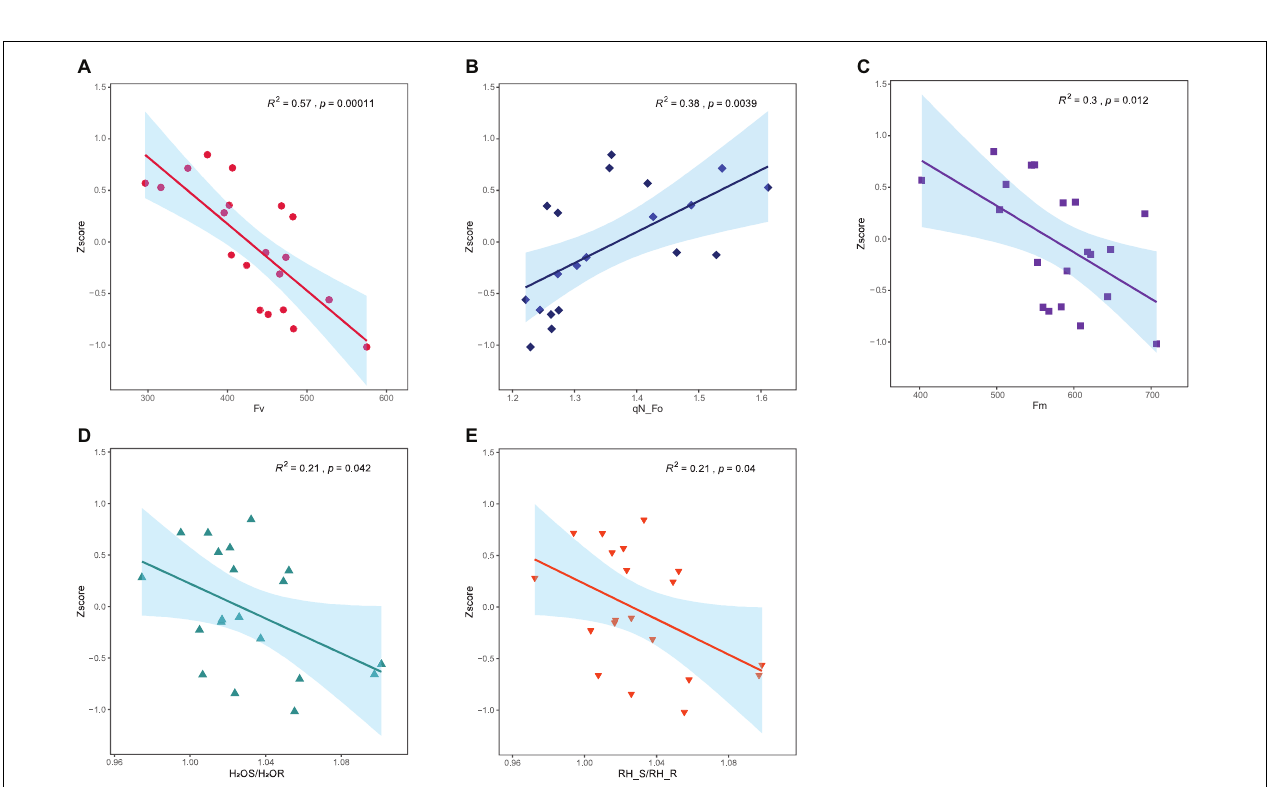
FIGURE 4 | Regression prediction of single feature. (A) Fv. (B) qN_Fo. (C) Fm. (D) H 2 OS/H 2 OR. (E) RH_S/RH_R.